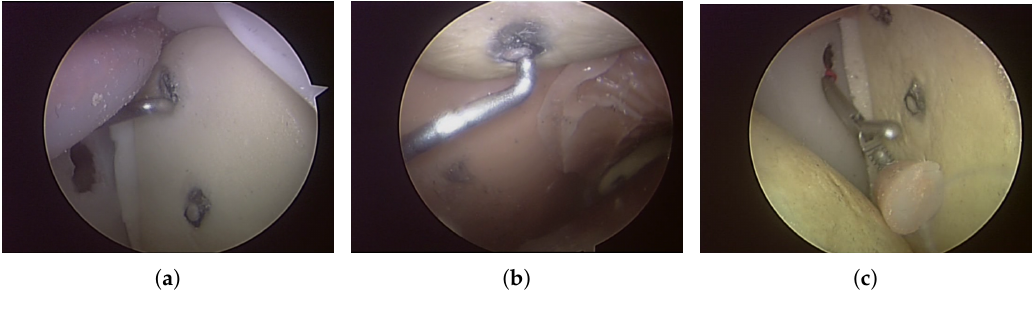
Figure 2. The arthroscopic tasks investigated in this study: ( a ) Task 1; ( b ) Task 2; and ( c ) Task